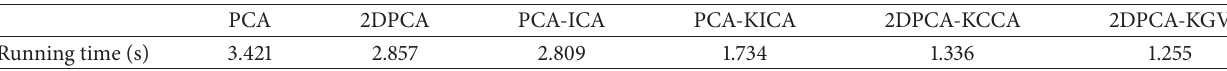
Table 2: Different dimension reduction effects of dimensional reduction methods for multidimensional feature